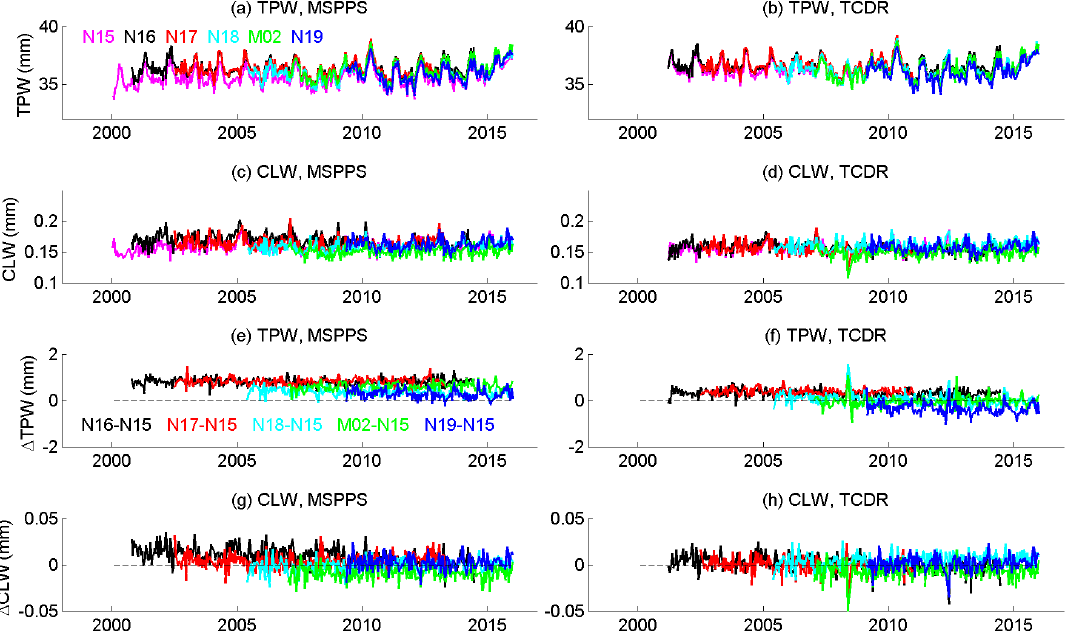
Figure 11. Retrieved tropical ocean products comparison, note different variables are used in different panels. Left panels display the products produced by MSPPS from 1b before inter-satellite calibration, while right panels are TCDR after inter-satellite calibration. Time series of total precipitable water (TPW) is shown in ( a , b ), the difference versus N15 is shown in ( e , f ); time series of cloud liquid water (CLW) is shown in ( c , d ), the difference versus N15 is shown in ( g , h ).